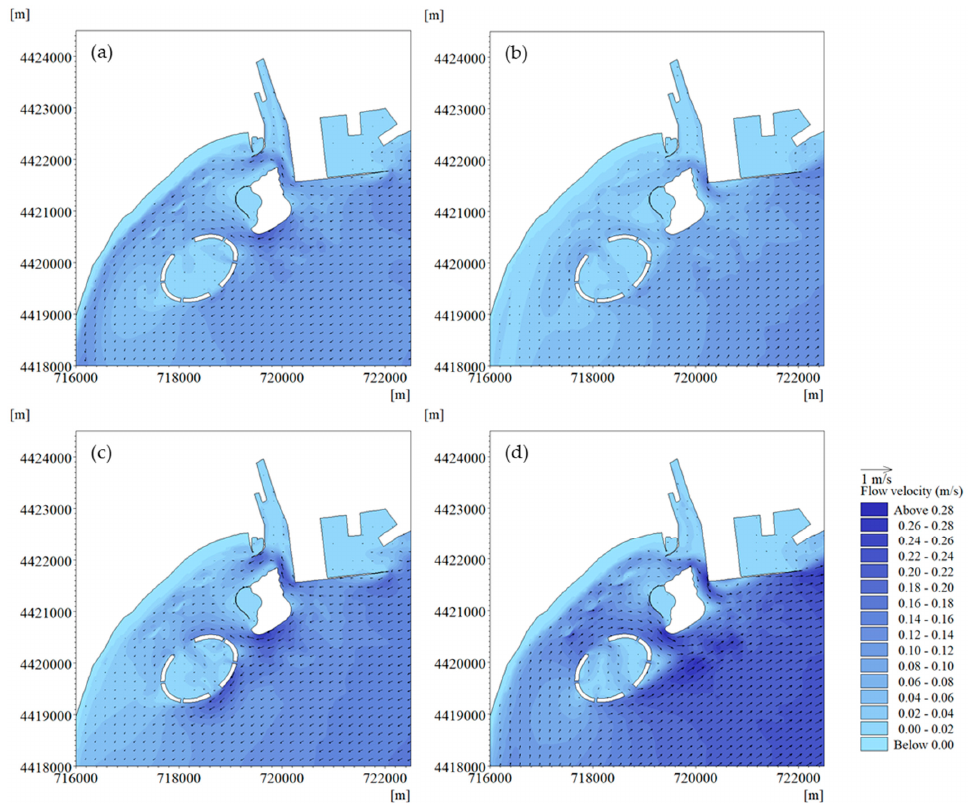
Figure 8. Flow fields at ( a ) the peak flood, ( b ) the peak ebb during a typical neap tidal period and ( c ) the peak flood, ( d ) the peak ebb during a typical spring tidal period, under the current construc- tion